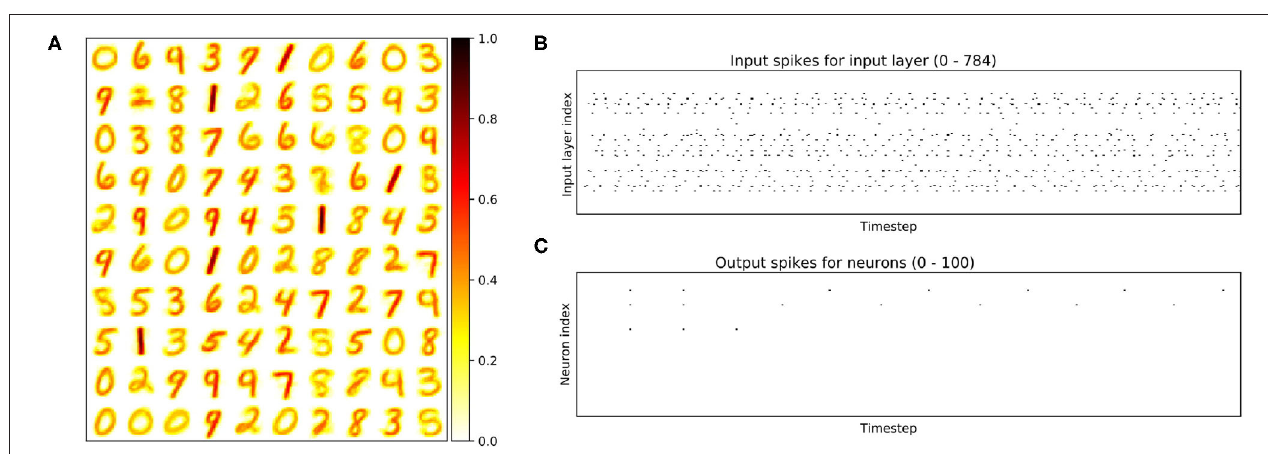
FIGURE 19 | Illustration of the STDP learning model. (A) the final weights. (B) Illustration of input spikes for the first test image (number 8). (C) Illustration of output spikes.